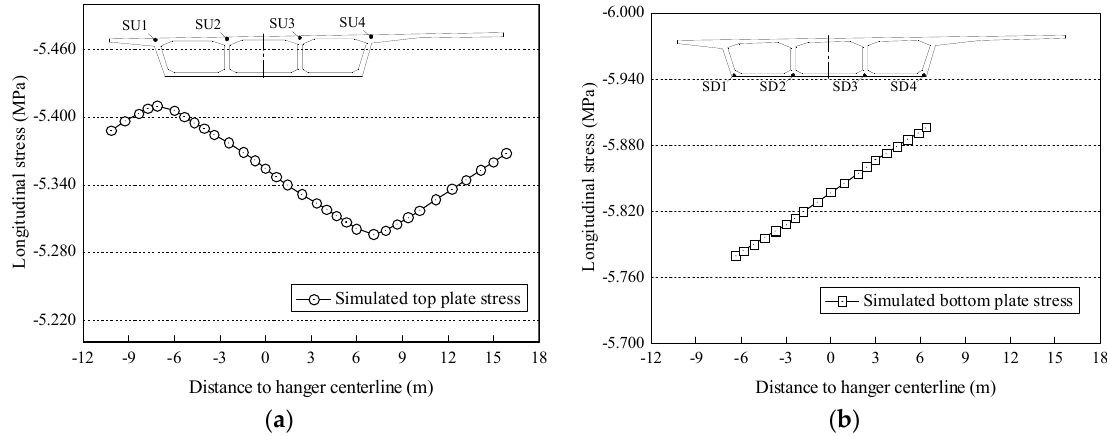
Figure 6. Simulated girder longitudinal stress at mid-span section CS5: ( a ) Top plate; and, ( b ) Bottom plate.